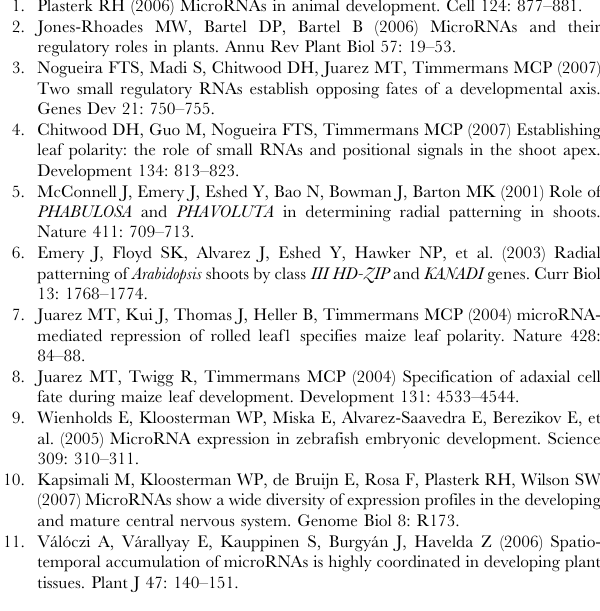
PCR amplification of mir166a - i precursor transcripts on total RNA isolated from hand-dissected vegetative apices and female inflorescences ( , 0.5–1 cm) shows that all nine mir166 genes are expressed in both tissues. The loading control tubulin6 (tub6) and - RT controls are shown. (B) Cartoon representing a mir166 precursor transcript with the miRNA* (blue) and mature miRNA (red) shown. Gene specific primers (arrows) were designed downstream of the stem-loop as indicated. Figure S2 tas3 genes are expressed broadly throughout the maize shoot apical meristem. Cells were captured by laser- microdissection from the tip of the SAM (5), the incipient leaf (6) and below the incipient leaf (7) as depicted in Figure 2 of the manuscript. mRNA isolated from these microdissected domains was linearly amplified and used in 1-step RT-PCR to monitor expression of tas3 family members. The tas3a - tas3d precursors are expressed broadly throughout the SAM, and only tas3a does not appear to be expressed in the tip of the SAM.